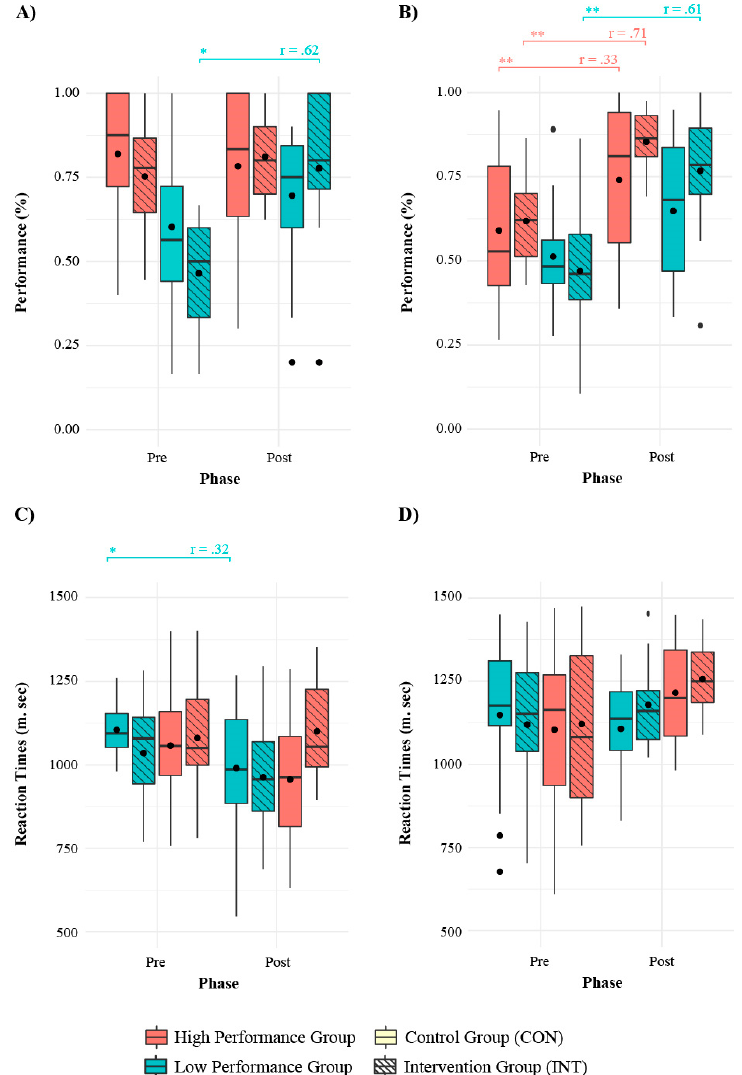
Figure 3. Performance values in pre- and post-training assessments for the performance and experimental groups. ( A ) Performance for the incongruent block of the Stroop task; ( B ) RT for the incongruent block of the Stroop task; ( C ) Performance for incongruent trials of the Child Attentional Networks Test (ANT); ( D ) RT for incongruent trials of the Child ANT.